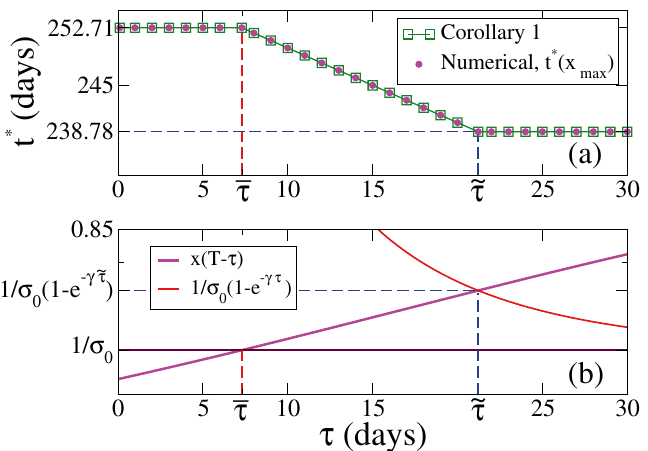
Figure 3. ( a ) Optimal initial time t ∗ vs strict quarantine length τ for κ = 0 and x 0 > 1 /σ f . ( b ) Graphical determination of the times τ and ˜ τ that define the three regions for the different behaviours of t ∗ . The parameters are γ = 0.1, σ m = σ f = 1.5, σ s = 0 and T = 260 . The initial condition corresponds to x ( 0 ) = 1 − 10 − 6 , y ( 0 ) = 10 − 6 ( R 0 = σ f x ( 0 ) > 1 ). The optimum times of the first and last regions are t ≃ 252.71 and ˜ t ≃ 238.78 , respectively, determined by τ ≃ 7.29 and ˜ τ ≃ 21.22